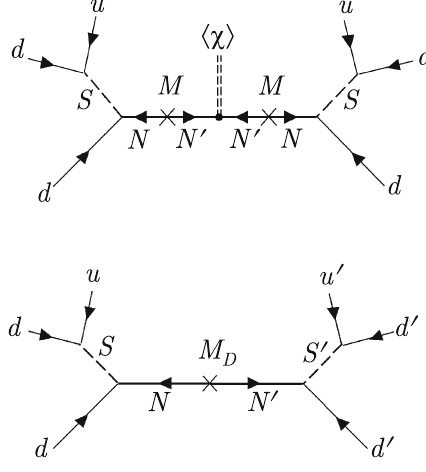
Fig. 4 The upper diagram with M D being the Dirac mass of heavy fermions generates n – ˜ n mixing after inserting the B − L symmetry breaking VEV (cid:5) χ (cid:6) . The lower diagram with twin mirror quarks u (cid:3) , d (cid:3) , connected to N (cid:3) , induces (without insertion of χ field) n – ˜ n (cid:3) mixing which conserves the combination of charges ¯ Q = ( B − L ) − ( B (cid:3) − L (cid:3)